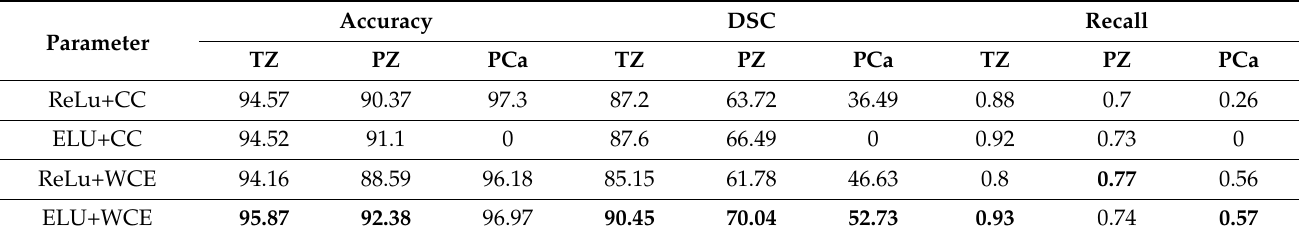
Table 3. The results of ablation study in Terms of the Loss functions and activation